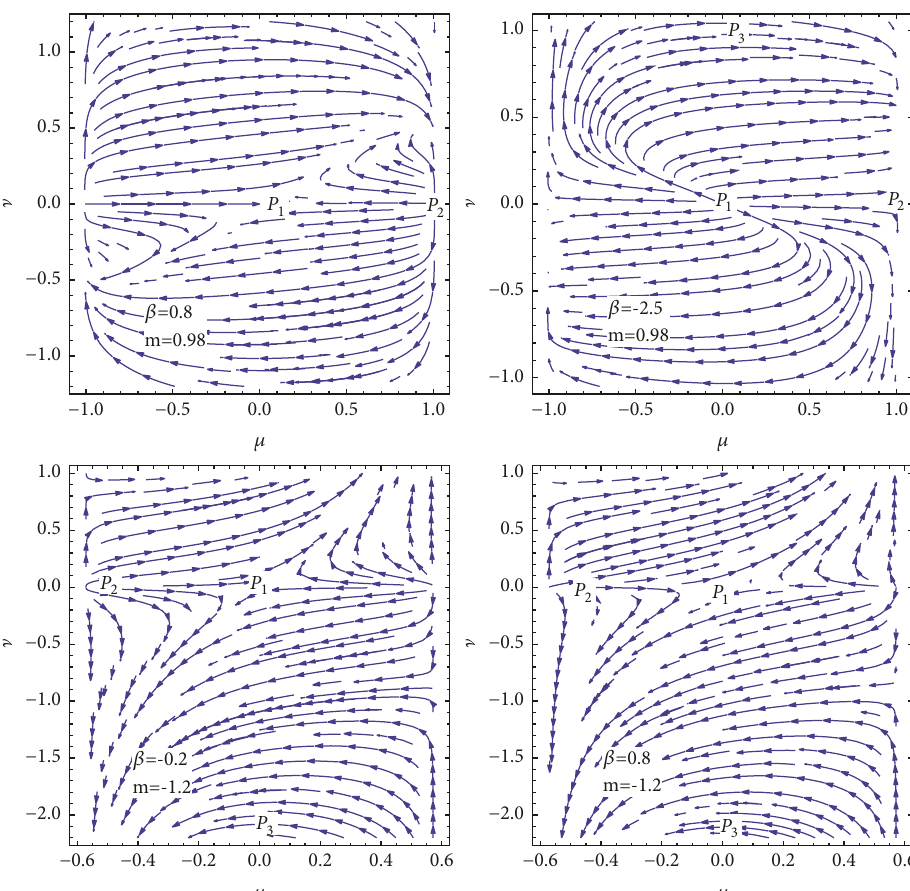
Figure 4: Plots for tachyon coupled cosmic model with 𝑄 = 𝛽 ̇𝜎 𝜙 and 𝜆 = 2 .